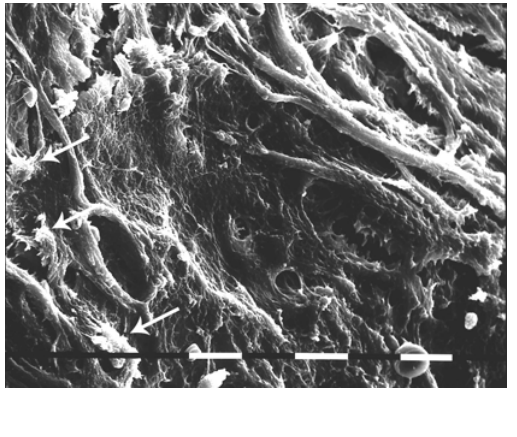
FIGURE 4. SEM micrograph of peri-implant tissue around SS implant 2 weeks after surgery. An osteoid tissue with calcifying collagen fibres observed around the implant surface between 2 threads. Osteocytes and rounded osteoblast-like cells appear to hold on to the collagen fibre network and partially included by the calcifying front (arrows). Bar = 10 µm.